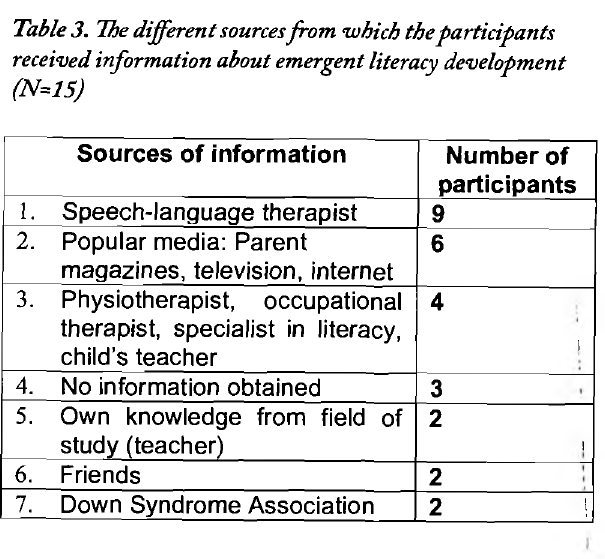
Table 3. The different sourcesfrom which the